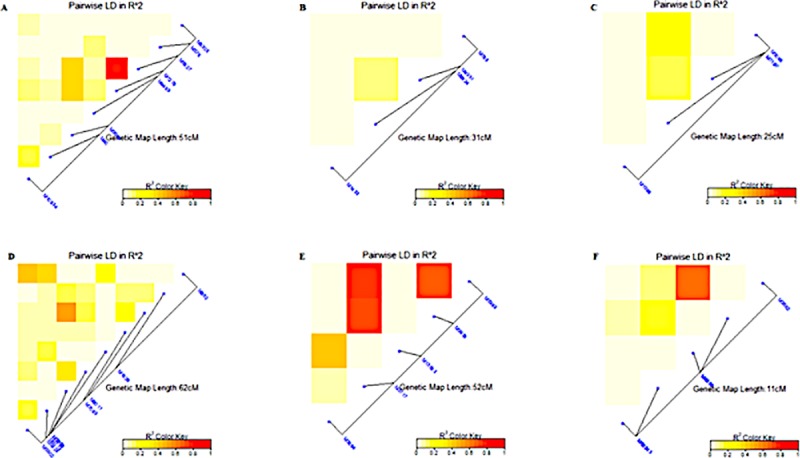
Summary of the local LD among markers with significant MTAs for different traits.A. DTH, B. DTM and C. RS under non-stress conditions and D. DTH, E. DTM and F. RS under drought-stress conditions. The R2 color key indicates the degree of significant association.